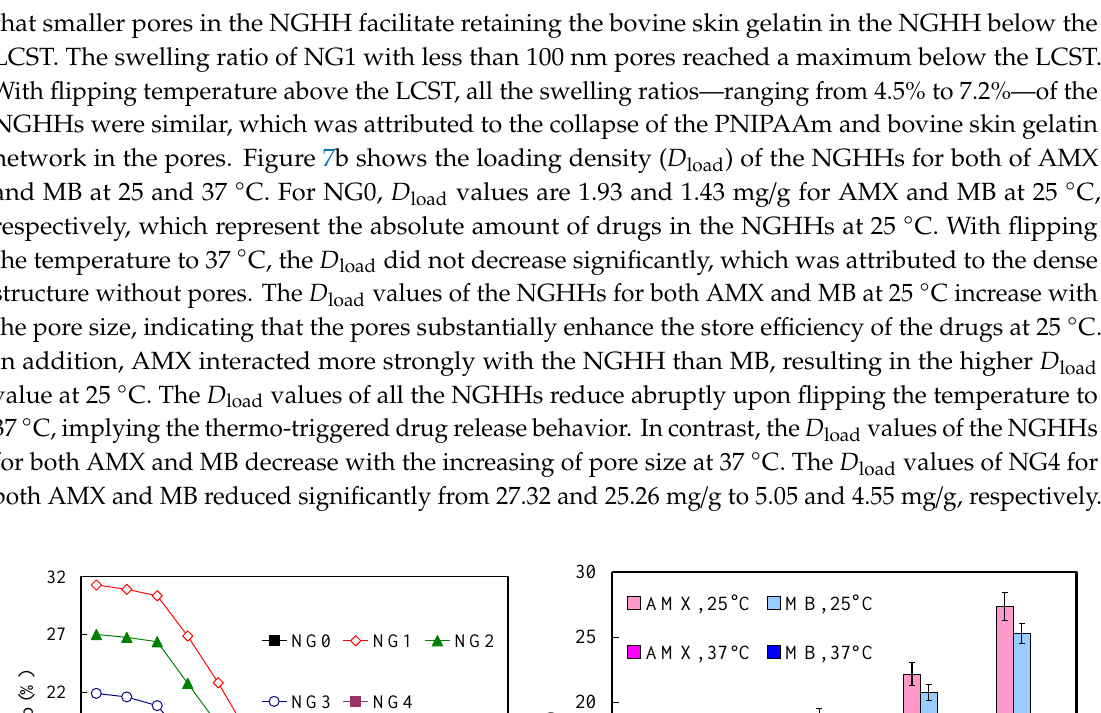
( b ) Figure 8. R cr of NG0, NG1, NG2, NG3, and NG4 ( a ) plotted with respect to temperature from 25 to 45 °C and ( b ) in real time over four stages: from 0 to 120 min at 25 °C, for the next 180 min in the bath of